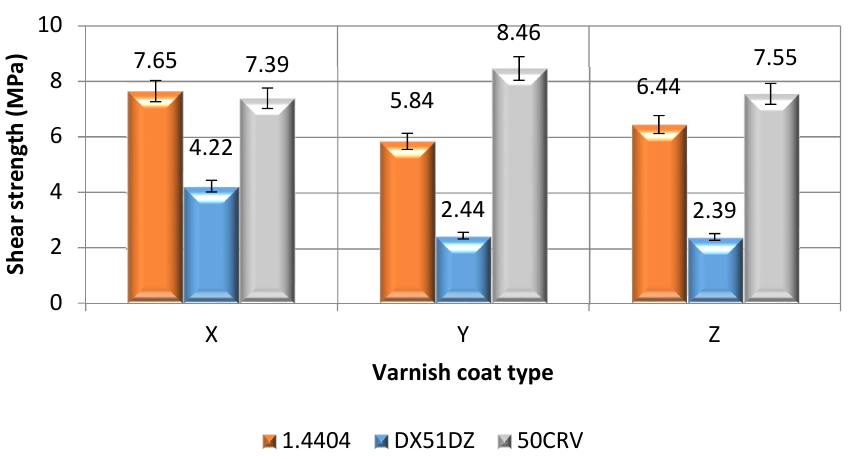
Figure 6. Shear strength of adhesive joints for samples with varnish coats, made with epoxy adhe- sive.